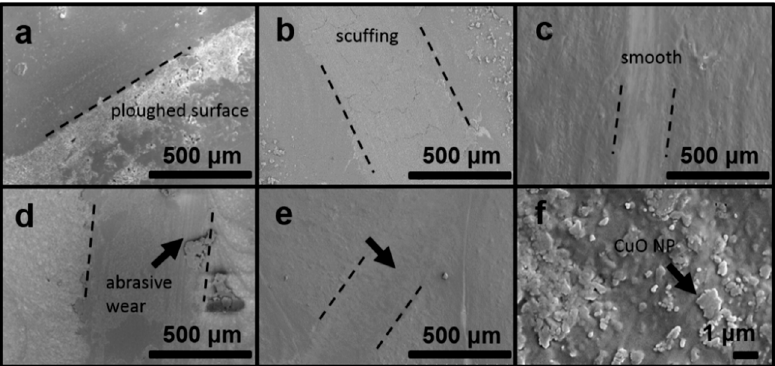
Figure 8. Worn surface of ( a ) HPMC/MoS 2 , ( b ) HPMC/MoS 2 /Al 2 wt.%, ( c ) HPMC/MoS 2 /Cu 2 wt.%, ( d ) HPMC/MoS 2 /Al 2 O 3 2 wt.%, ( e ) HPMC/ MoS 2 /CuO 2 wt.%; ( f ) enlarged arrow indicates the place in ( e ) (sliding distance 50 m).